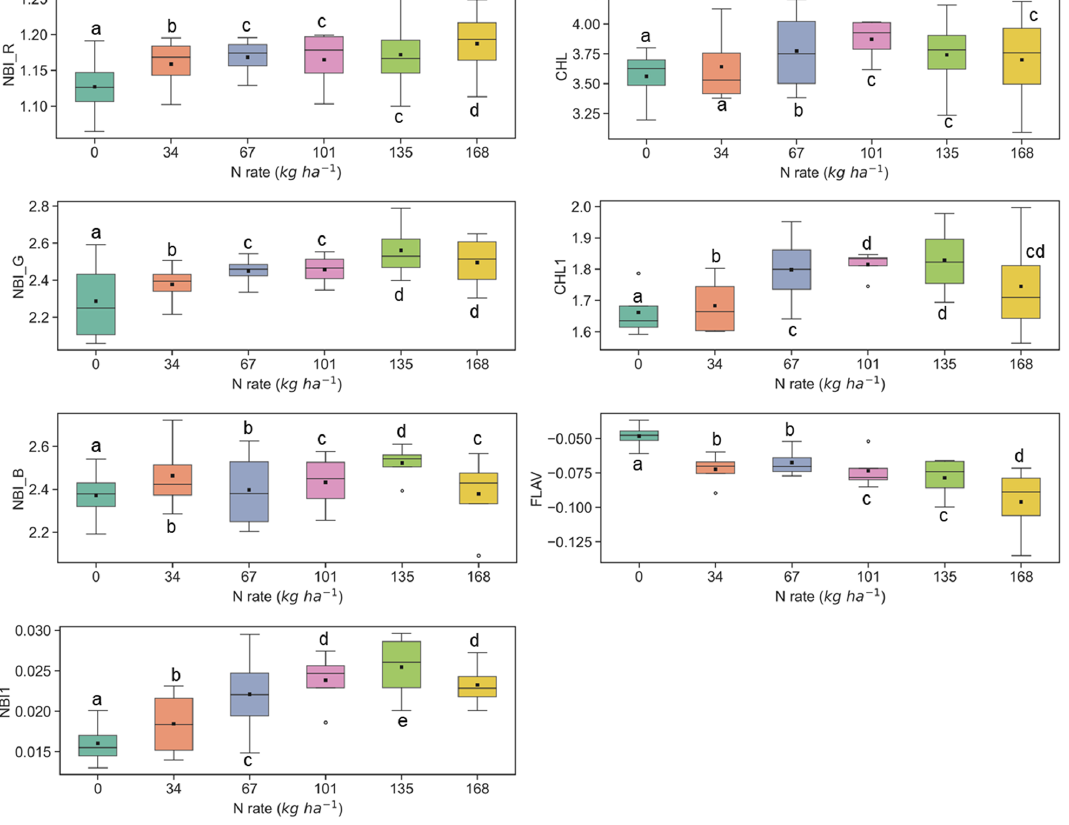
Figure 5. Response of Multiplex fluorescence indices over maize canopy treated with different N application rates at the V6 growth stage at the Iliff site. Different letters (a, b, c, d, e) indicate significant differences according to the Tukey’s HSD test at p < 0.05 significance level.